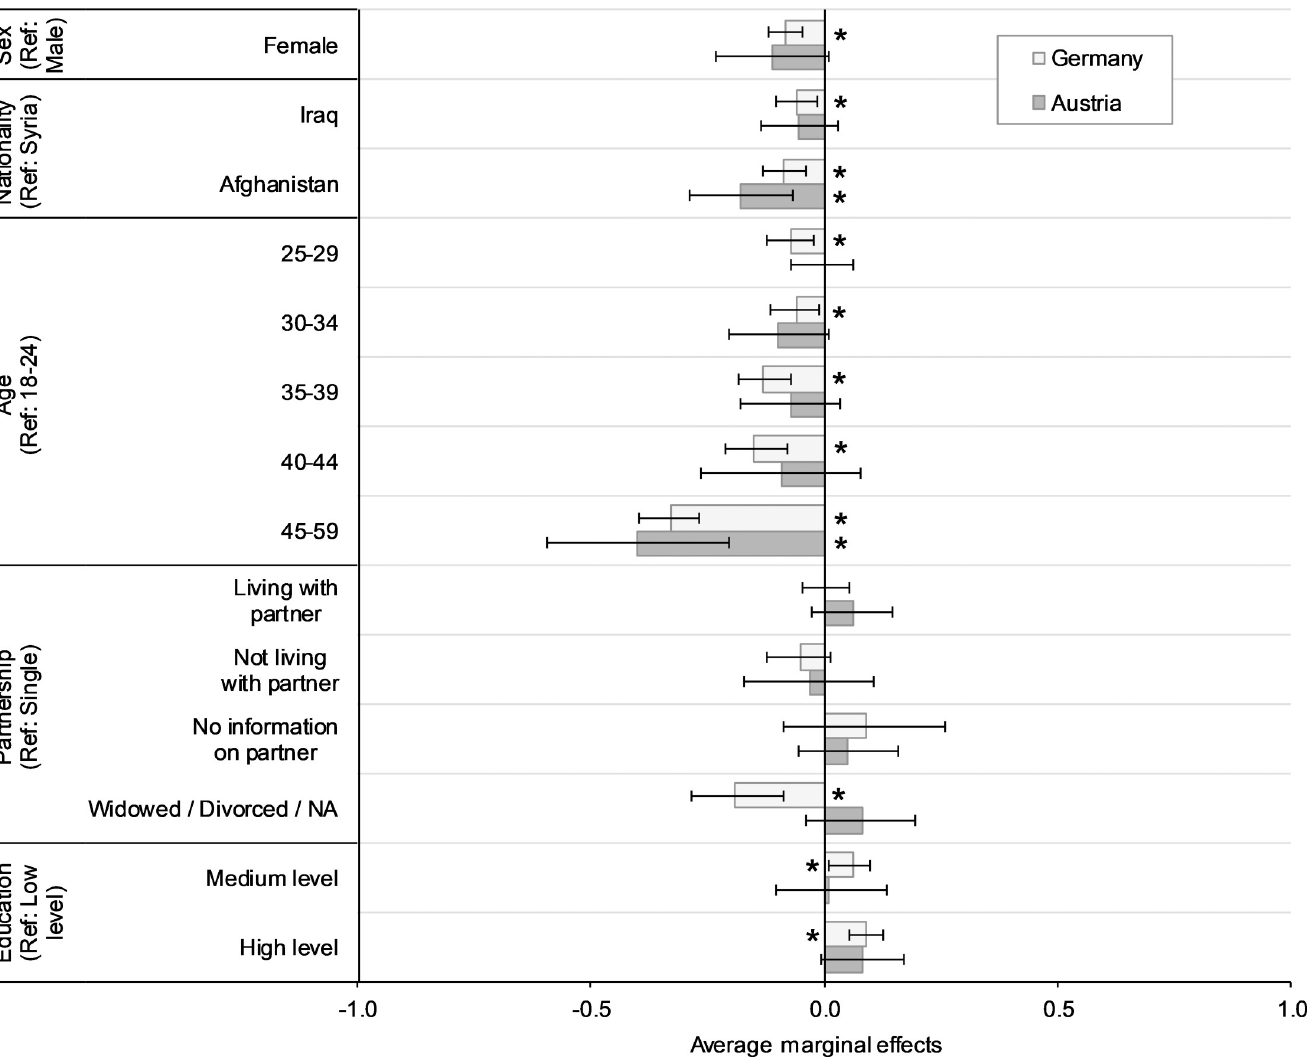
Fig 1. Average marginal effects for sex, nationality, age, partnership status, and education; by country. Sources: IAB-BAMF-SOEP 2016, ReHIS; Remark: Average marginal effects as estimated in model 1 in Table 2. Asterisks denote significant within-country differences compared to the reference group (Ref) (p < 0.05).